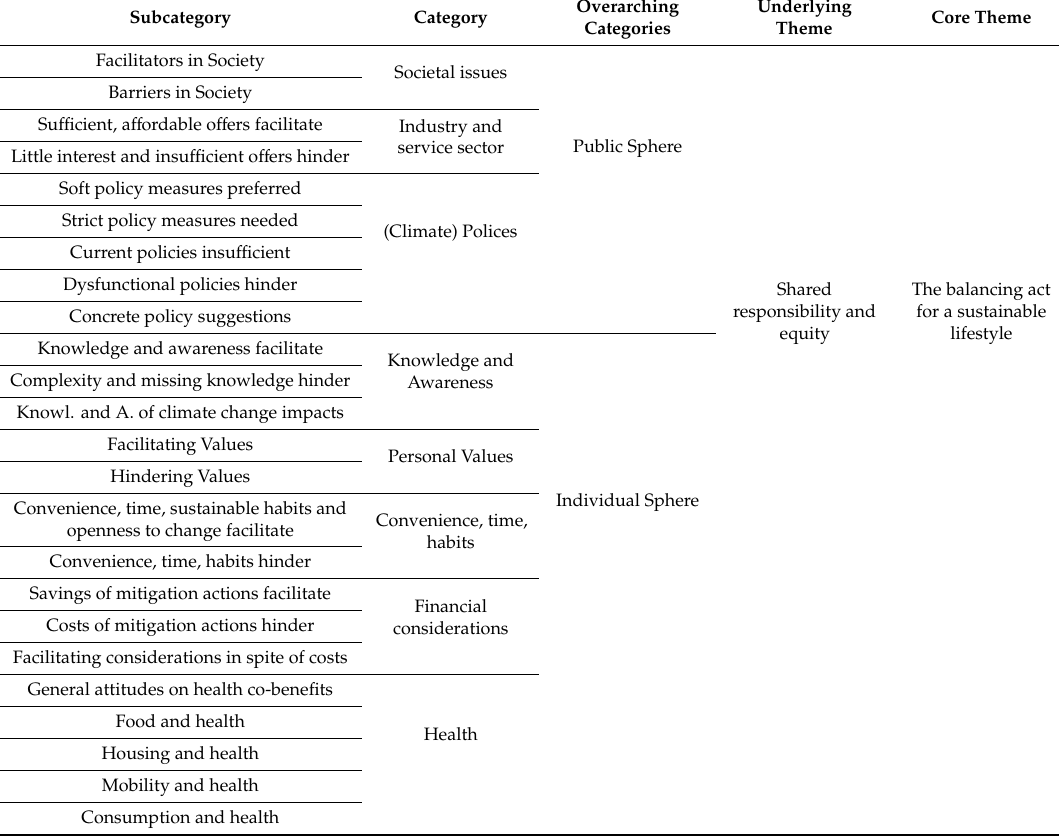
Table 3. Overview of subcategories, categories and overarching categories leading to